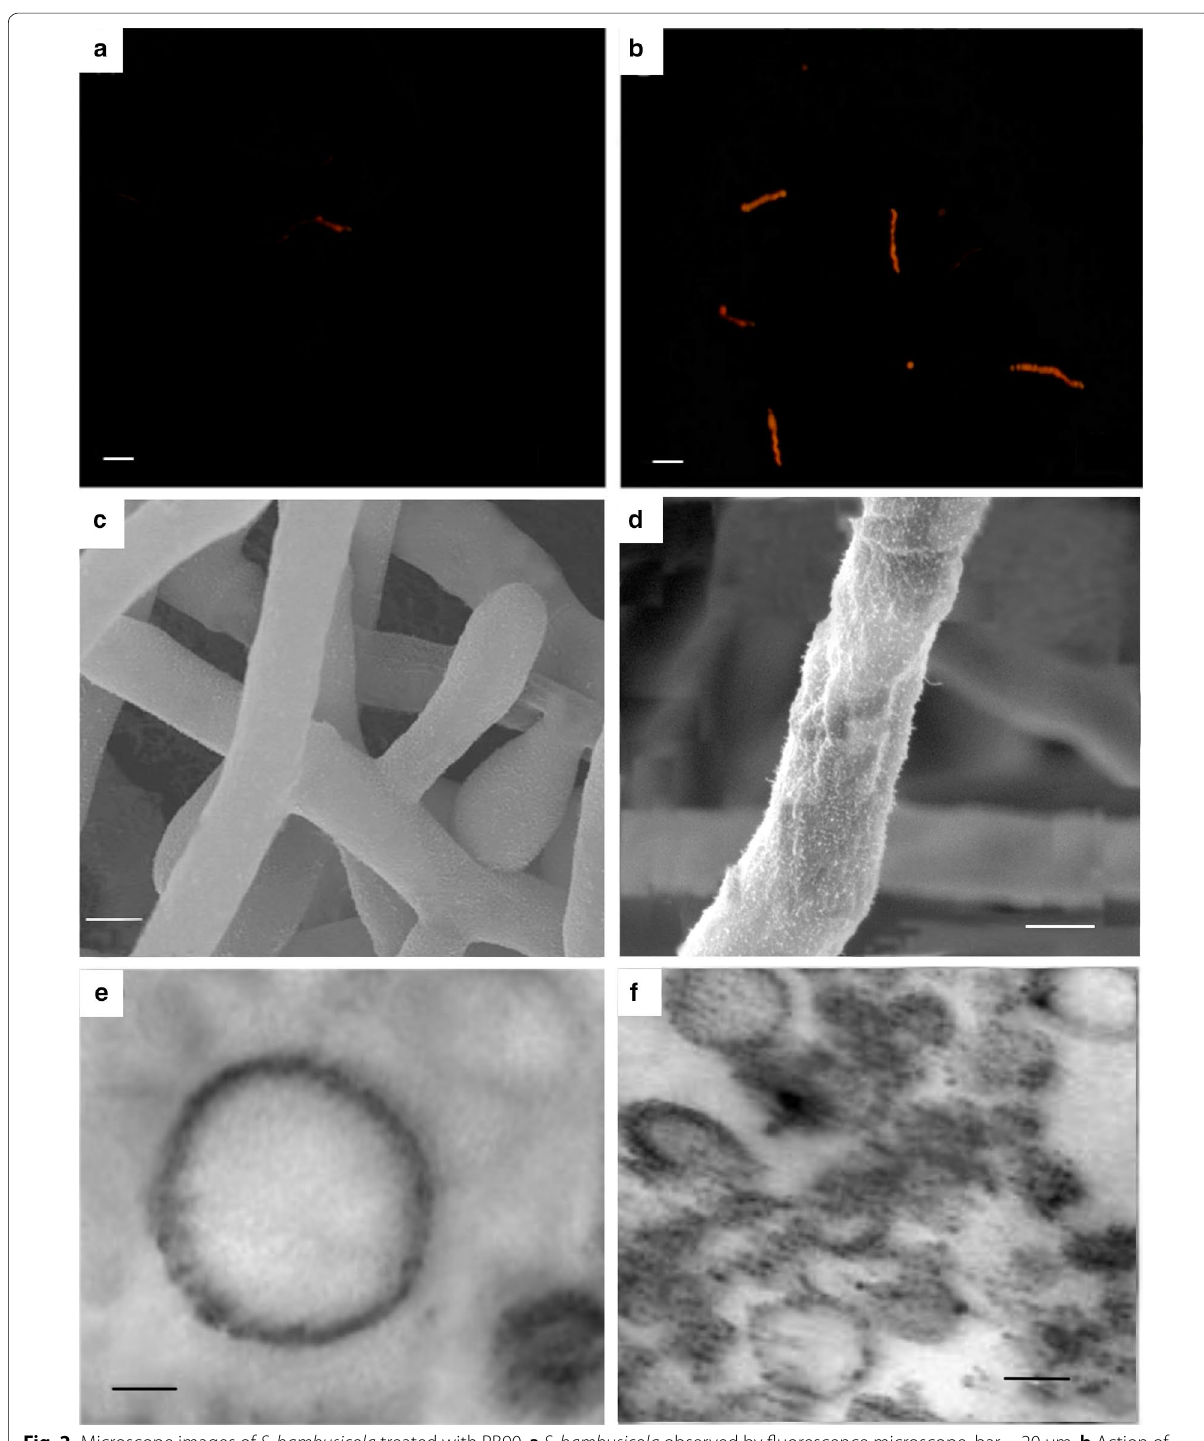
Fig. 2 Microscope images of S. bambusicola treated with PB90. a S. bambusicola observed by fluorescence microscope, bar 5 nmol/L PB90 on S. bambusicola by fluorescence microscope,